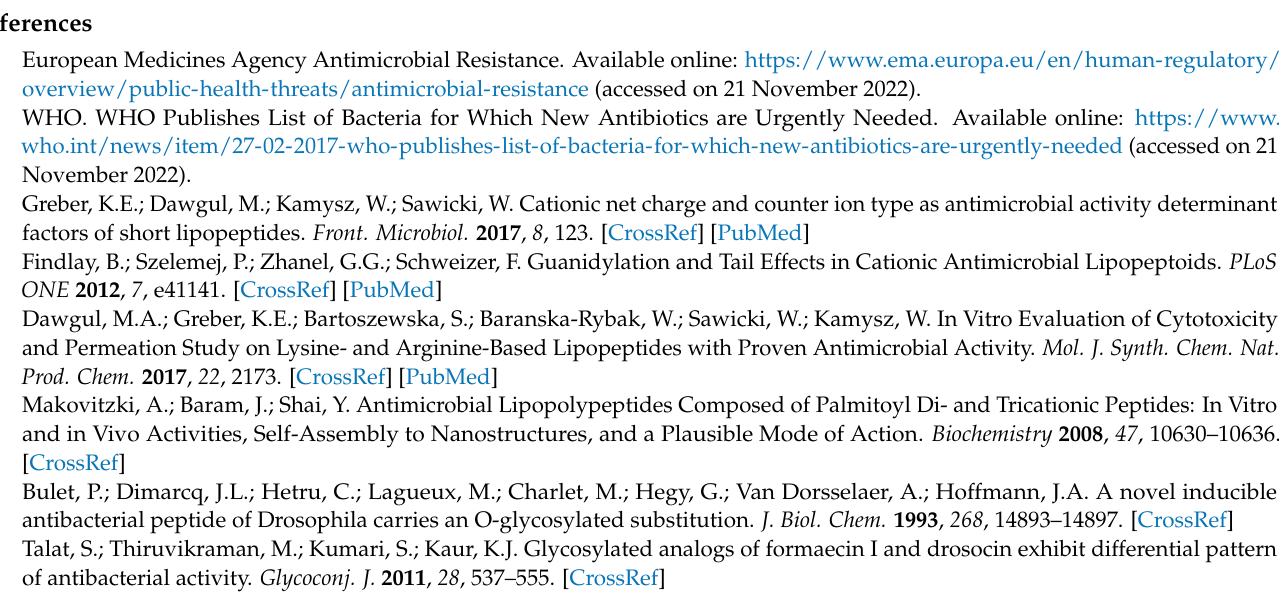
time for E. fecium .; Figure S2: Log 2 MIC vs. adjusted retention time for S. aureus .; Figure S3: Log 2 MIC vs. adjusted retention time for K. pneumoniae. ; Figure S4: Log 2 MIC vs. adjusted retention time for A. baumannii. ; Figure S5: Log 2 MIC vs. adjusted retention time for P. aeruginosa .; Figure S6: Log 2 MIC vs. adjusted retention time for K. aerogenes .; Figure S7: Log 2 MIC vs. adjusted retention time for C. glabrata .; Figure S8: Log 2 SI (HC 50 ) vs. adjusted retention time for E. fecium .; Figure S9: Log 2 SI (HC 50 ) vs. adjusted retention time for S. aureus .; Figure S10: Log 2 SI (HC 50 ) vs. adjusted retention time for K. pneumoniae. ; Figure S11: Log 2 SI (HC 50 ) vs. adjusted retention time for A. baumannii .; Figure S12: Log 2 SI (HC 50 ) vs. adjusted retention time for P. aeruginosa.; Figure S13: Log 2 SI (HC 50 ) vs. adjusted retention time for K. aerogenes.; Figure S14: Log 2 SI (HC 50 ) vs. adjusted retention time for C. glabrata.; Figure S15: Log 2 SI (IC 50 ) vs. adjusted retention time for E. fecium.; Figure S16: Log 2 SI (IC 50 ) vs. adjusted retention time for S. aureus.; Figure S17: Log 2 SI (IC 50 ) vs. adjusted retention time for K. pneumoniae.; Figure S18: Log 2 SI (IC 50 ) vs. adjusted retention time for A. baumannii.; Figure S19: Log 2 SI (IC 50 ) vs. adjusted retention time for P. aeruginosa.; Figure S20: Log 2 SI (iC 50 ) vs. adjusted retention time for K. aerogenes.; Figure S21: Log 2 SI (IC 50 ) vs. adjusted retention time for C.